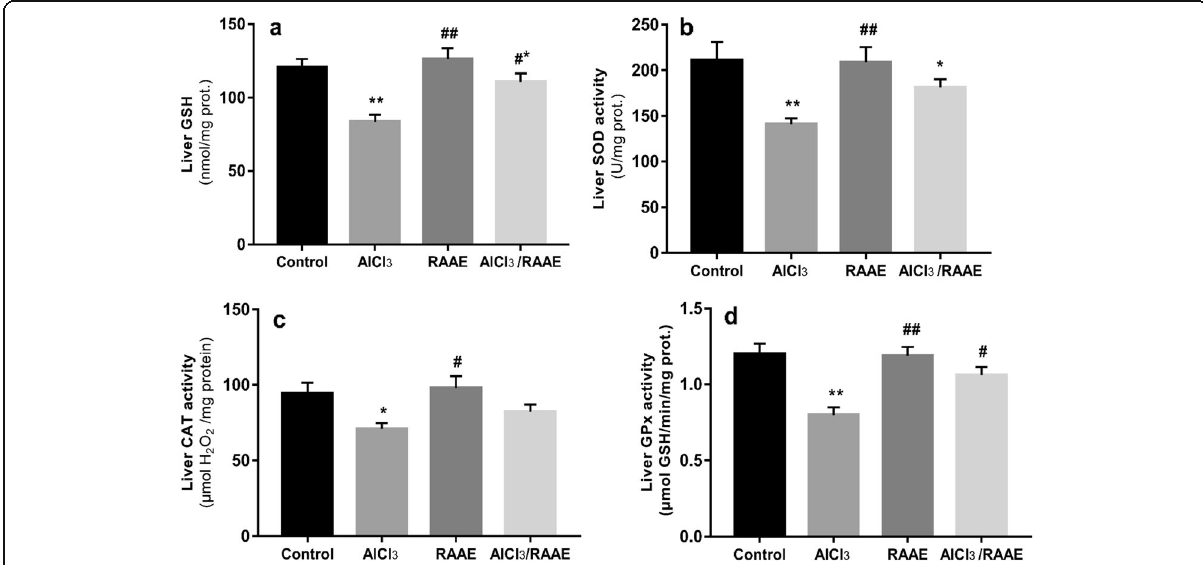
Fig. 2 Reduced glutathione content (a) , and SOD (b) , CAT (c) , and GPx (d) activities in liver of control and experimental groups. Data are expressed as mean ± SEM (n = 6 rats/group). AlCl 3 , Aluminium Chloride; RAAE, R. alaternus aqueous extract; GSH, reduced glutathione; SOD, superoxide dismutase; CAT, catalase; GPx, glutathione peroxidase. Significant difference compared to the control group ( ** p <0.01, * p <0.05); Significant difference compared to the AlCl 3 treated group ( ## p <0.01, # p